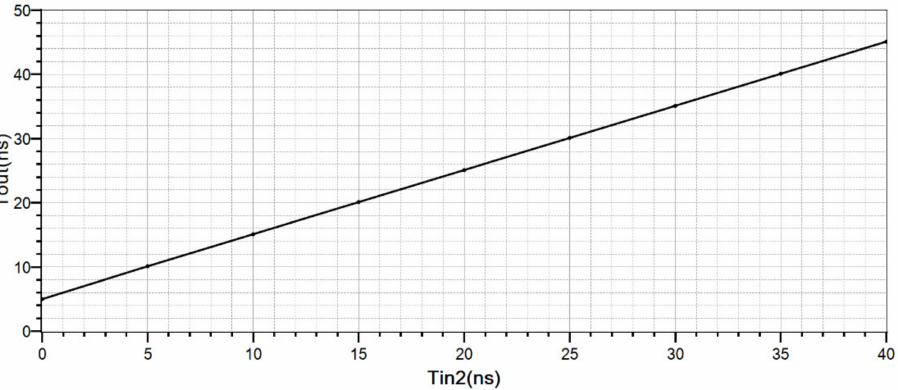
Figure 13. Input-output of a 2-input adder for a constant T in 1 = 5 ns, while T in 2 ranges between 0 and 40